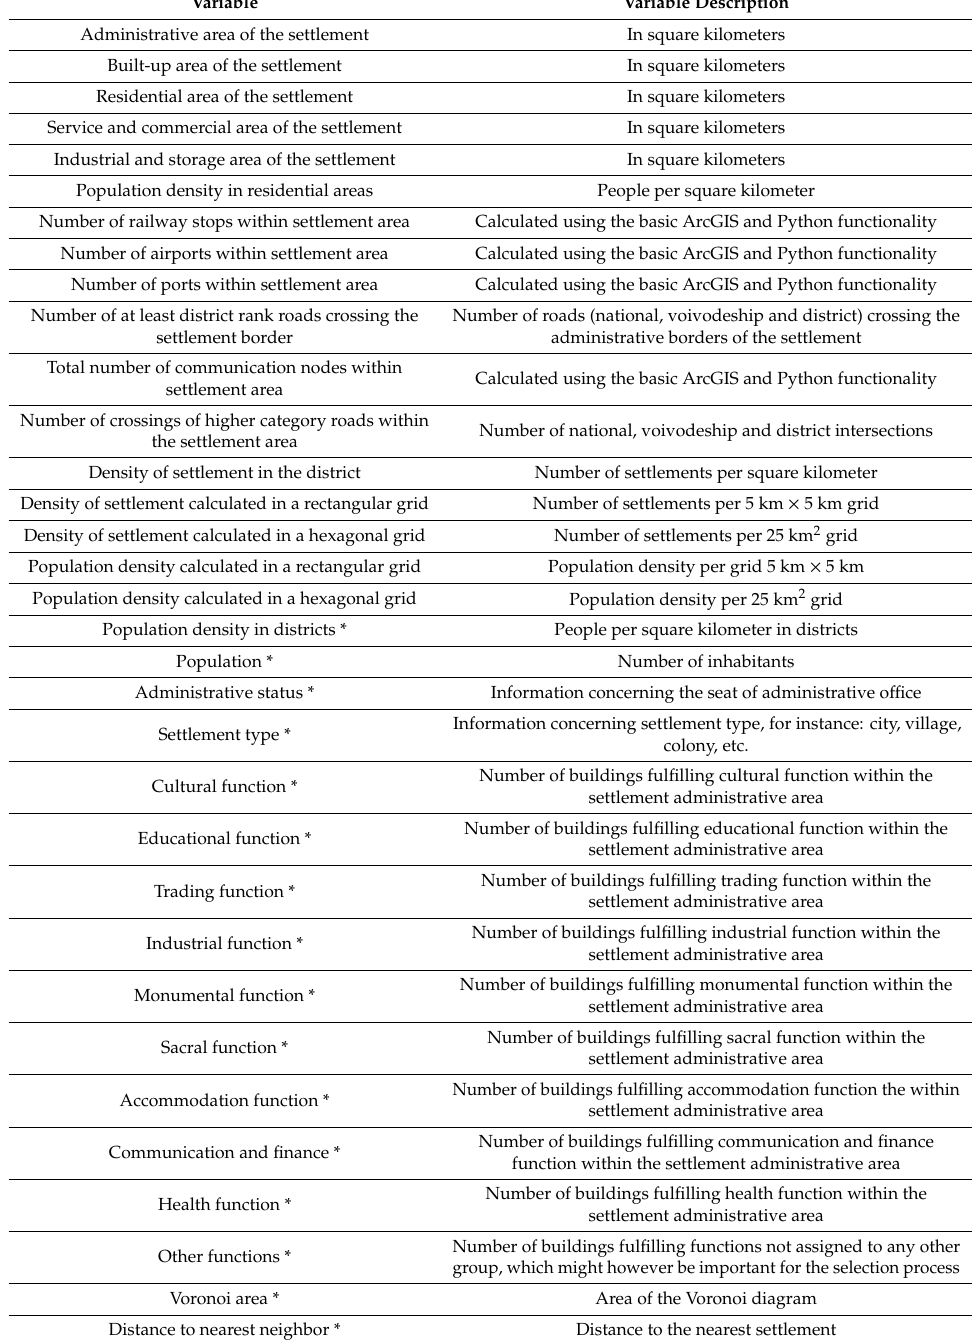
Table 2. Variables with their description. The variables proposed by Karsznia and Weibel [33] have been marked with